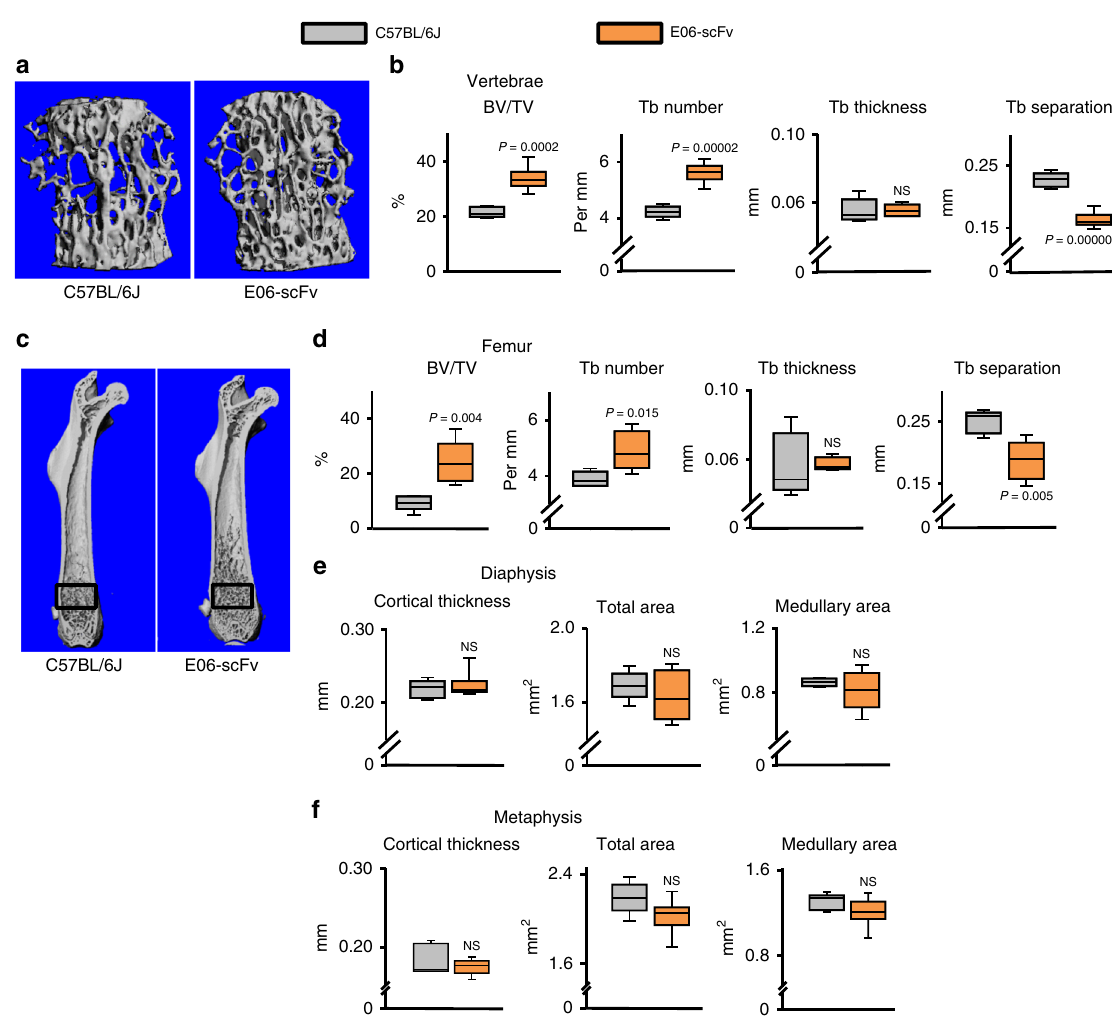
Fig. 5 Overexpression of E06-scFv increases cancellous bone in mice fed a normal diet. Micro-CT determination of ( a , b ) vertebral, and ( c – f ) femoral bone architecture in 5-month-old male mice fed a normal diet. a Lateral images of vertebral cancellous bone. b Quanti fi cation of vertebral cancellous bone architecture. c Longitudinal images of femur with proximal end at the top. Boxes indicate area of quanti fi cation of cancellous bone. d Quanti fi cation of cancellous bone architecture. e Quanti fi cation of diaphyseal cortical architecture. f Quanti fi cation of metaphyseal cortical architecture. C57BL/6 J n = 5, E06-scFv n = 6. Data analyzed by two-tailed Student ’ s t -test. Data shown represent the mean (±SD). BV/TV: bone volume /total volume, Tb: